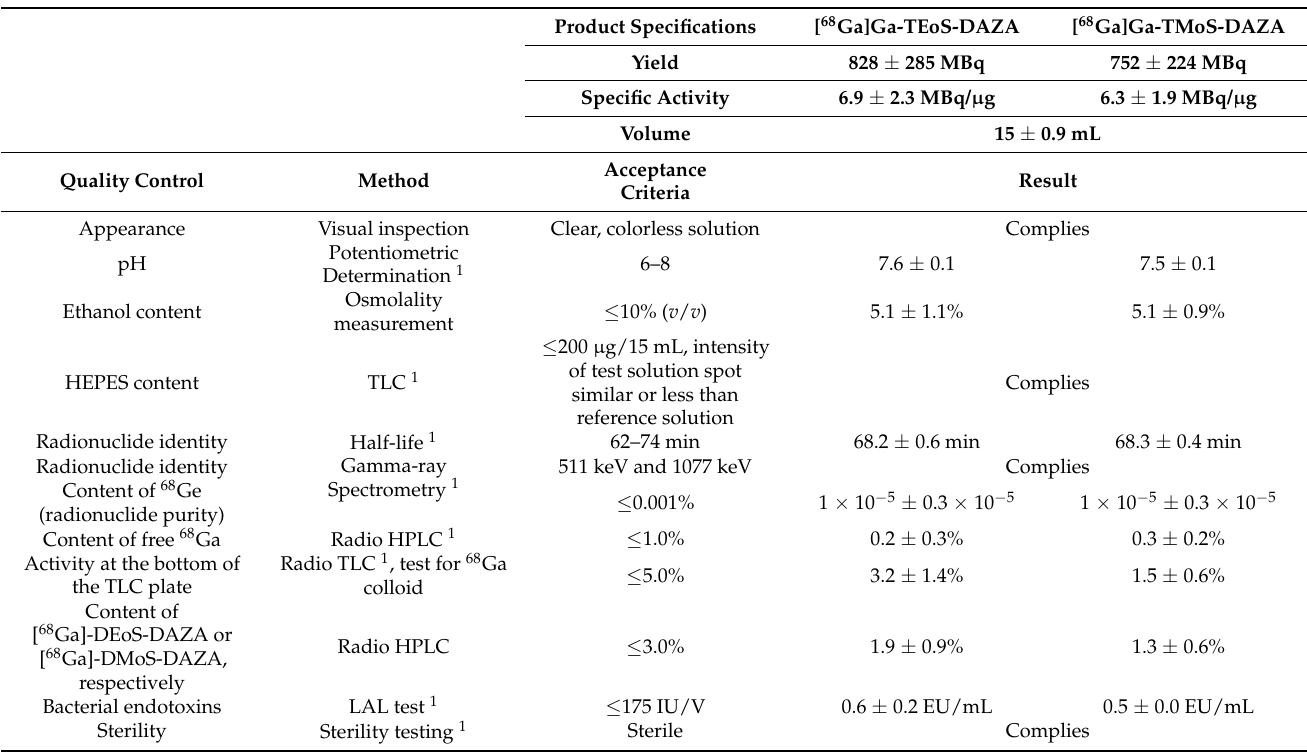
Table 1. Quality control specifications of [ 68 Ga]Ga-TEoS-DAZA and [ 68 Ga]Ga-TMoS-DAZA pro- duced on the synthesizer.